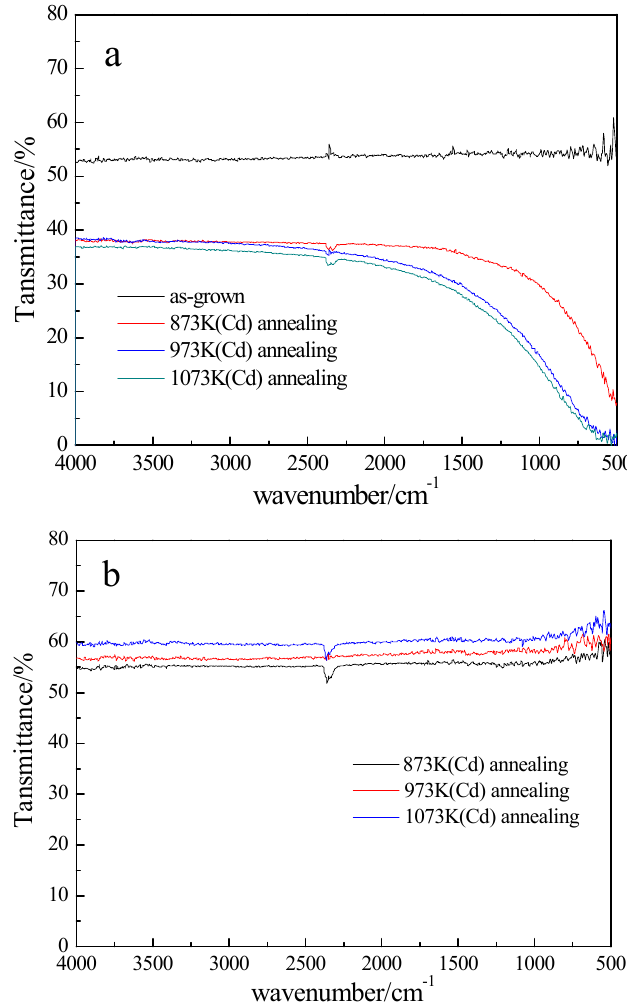
Figure 7. IR transmittance curves of CMT:In crystals before and after annealing: ( a ) Cd atmosphere; ( b ) Te atmosphere.